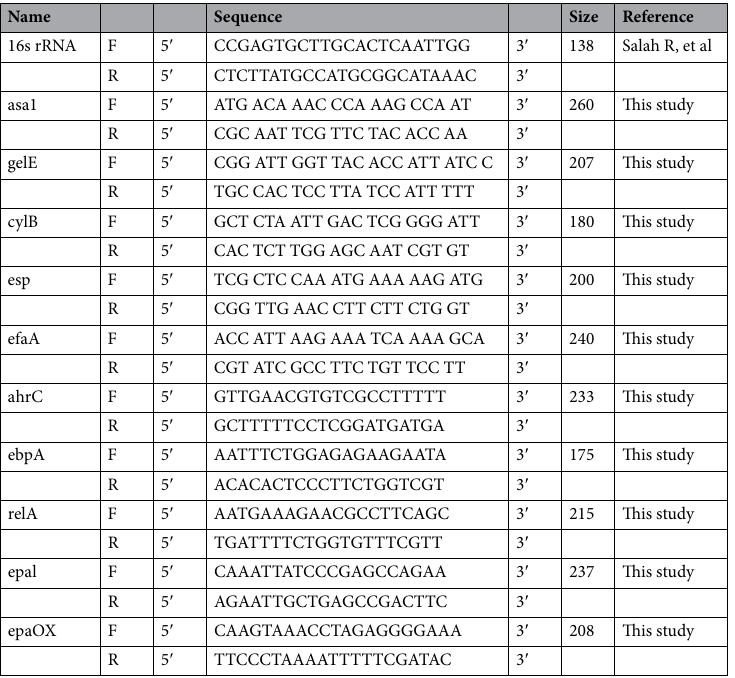
Table 1. Sequence of primers for